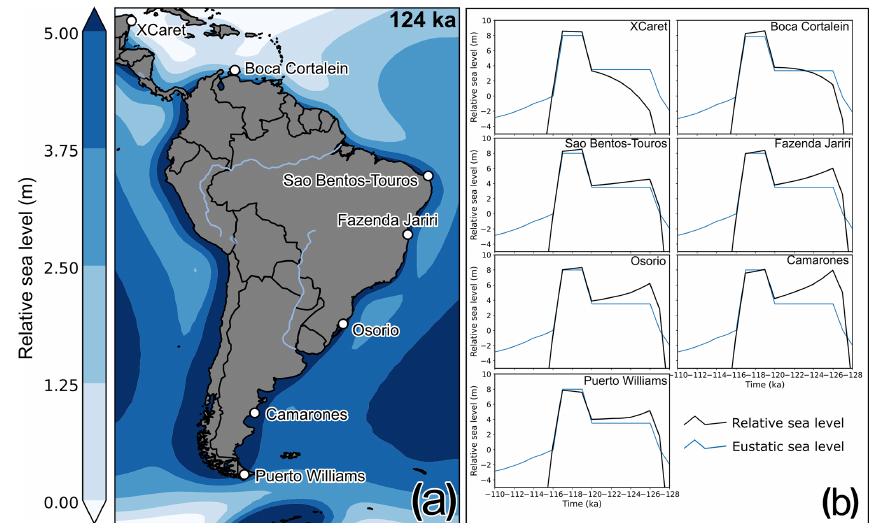
Figure 11. (a) Relative sea level as predicted by the ANICE–SELEN model at 124ka along a transect including selected sites in our review and those of Gowan et al. (2021) and Simms (2021); (b) time vs. RSL at each location shown in (a)